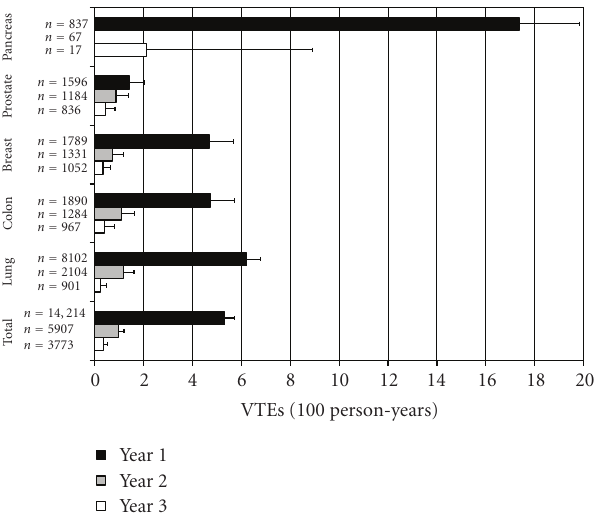
Figure 2: Incidence of VTE according to cancer type and time. Incidence of VTE within each year after cancer diagnosis is shown with error bars depicting standard